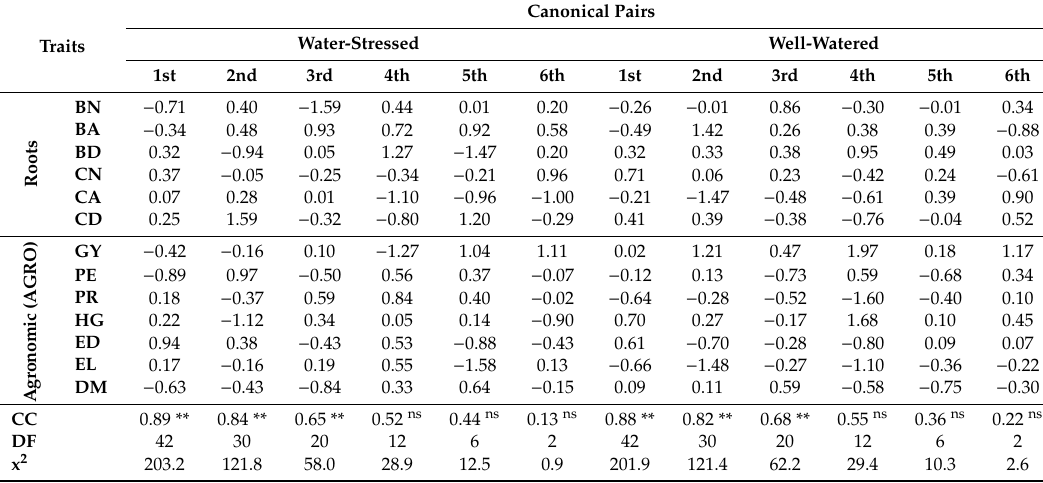
Table 3. Correlation and coe ffi cients of canonical pairs estimated between roots morphology and agronomic traits in 20 popcorn inbred lines under two di ff erent water conditions. Canonical Pairs Water-Stressed Traits